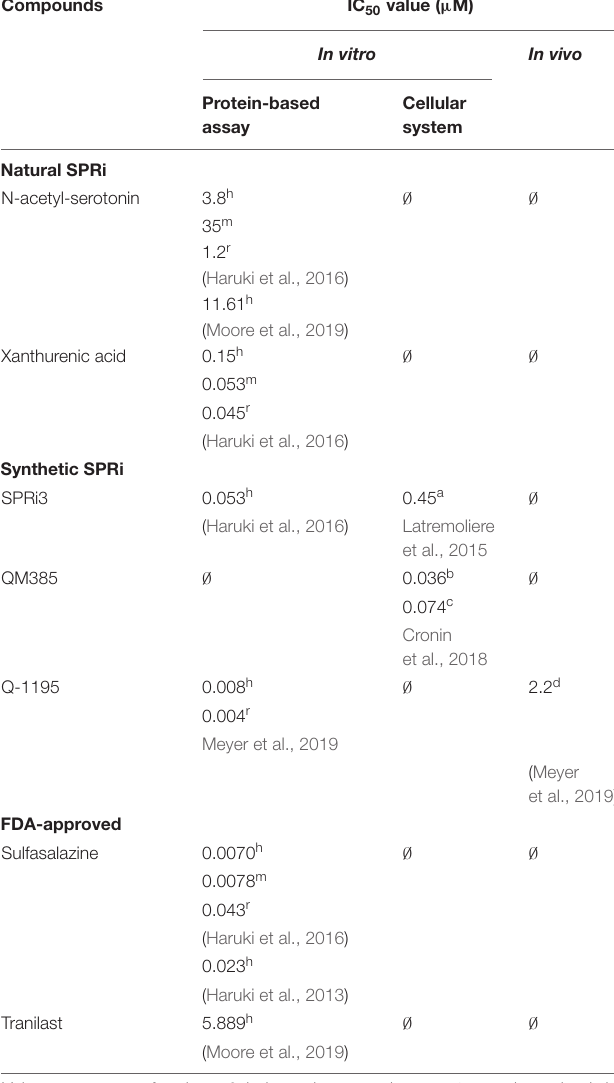
TABLE 1 | Half maximal inhibitory concentration (IC 50 ) for the known sepiapterin reductase inhibitors (SPRi). Compounds